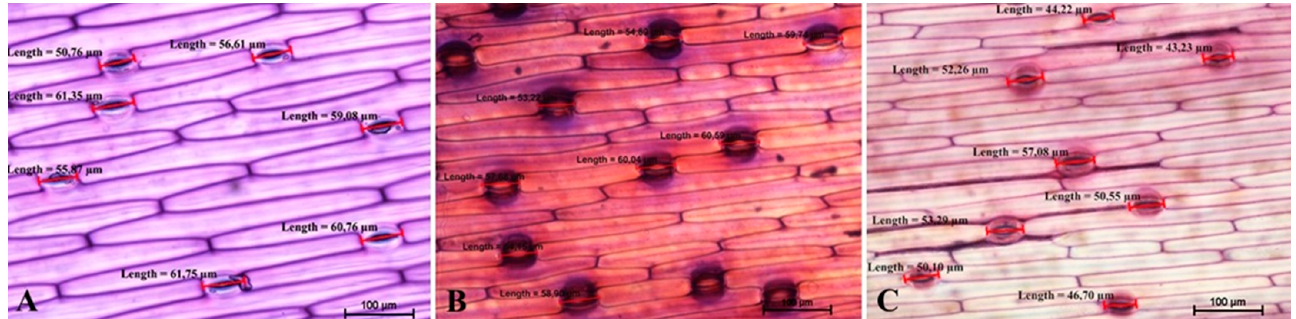
Figure 1. Microscopic images of the stomata seen on the abaxial side of narcissus leaves, along with their marked length: ( A ) breeding clone 0.1138-a; ( B ) cultivar ‘Beersheba’; and ( C ) cultivar ‘Roseate Hues’.